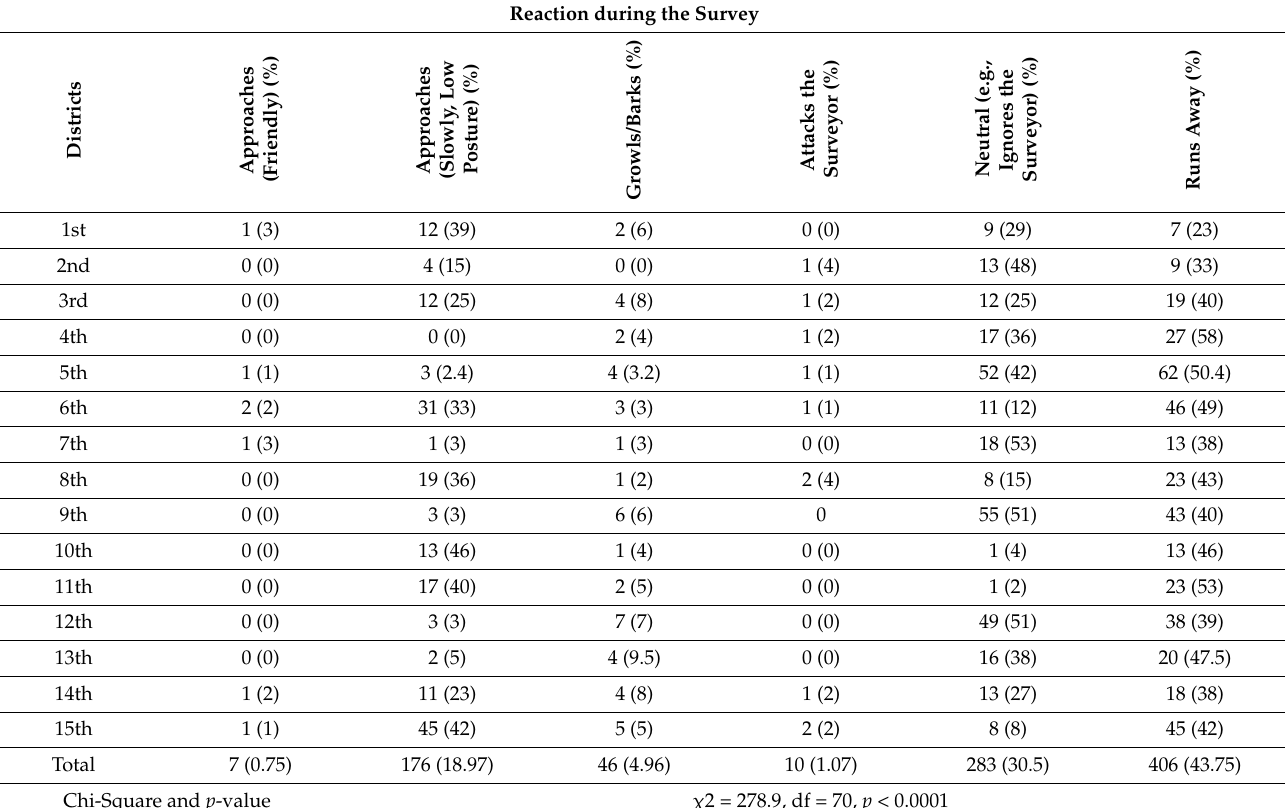
Table 3. Details of reactions of sighted FRDs during the survey period in each district of Herat city. Reaction during the